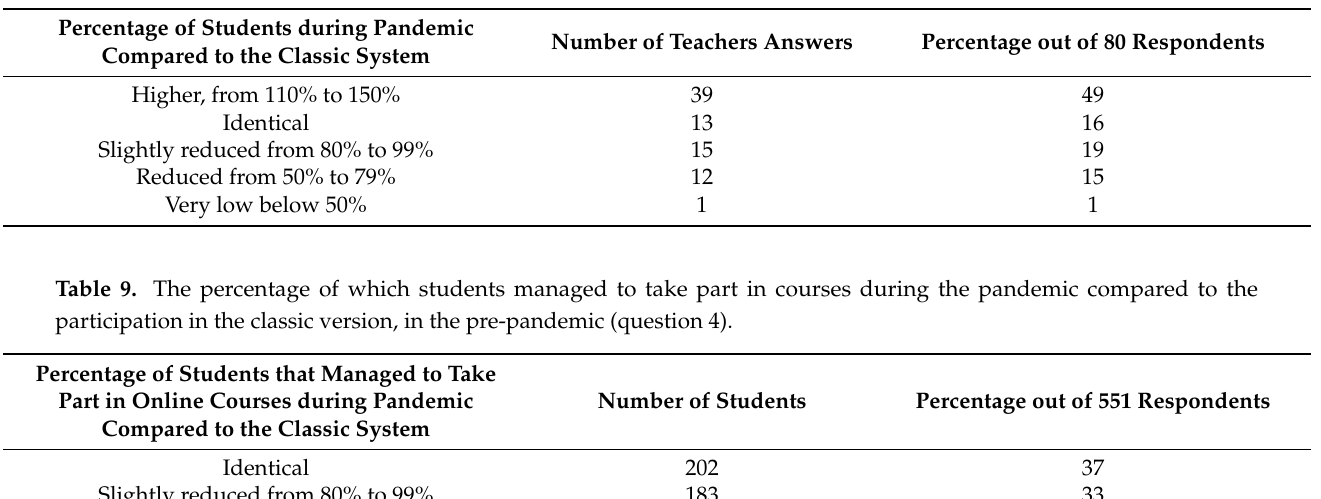
Table 8. Participation of students in online courses compared to the participation in classes conducted in the classic version, prior to the pandemic, in the teacher’s opinion (question 2).